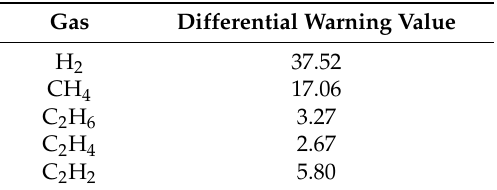
Table 4. The differential warning value of the gas